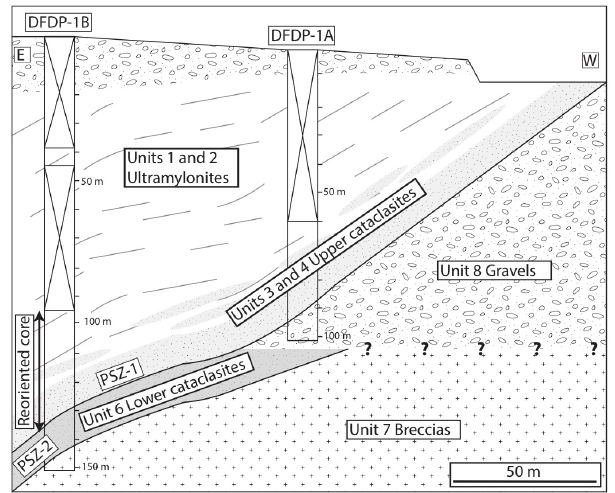
Figure 3. Cross section through the DFDP-1 boreholes, showing interval where reoriented drill core is located. Boxes with diag- onal lines depict intervals in the borehole with no core recovery; grey lines represent mylonitic foliation. Modified from Sutherland et al. (2012), with lithological units previously defined by Toy et al.